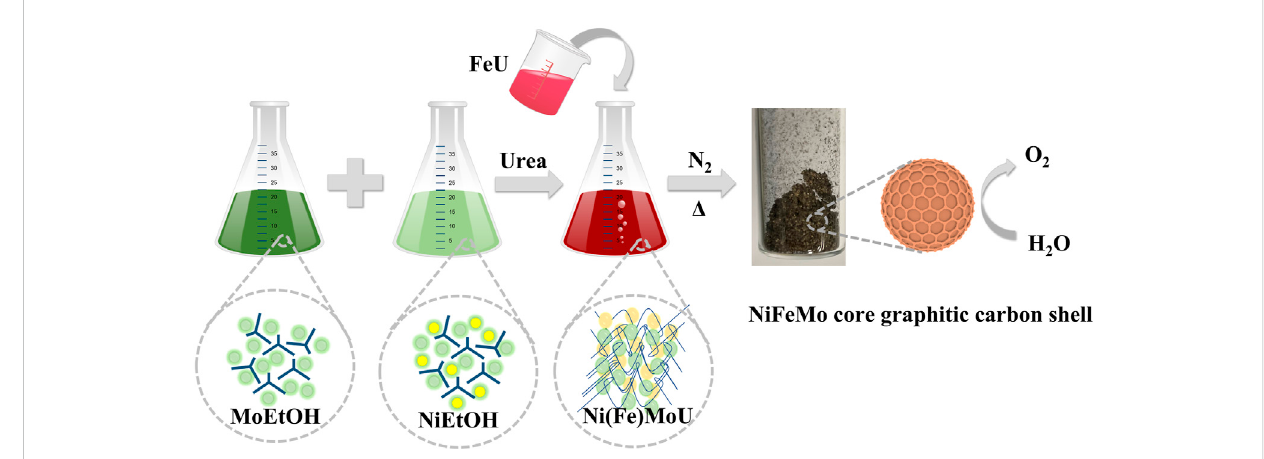
FIGURE 1 Schematic representation of the urea-glass